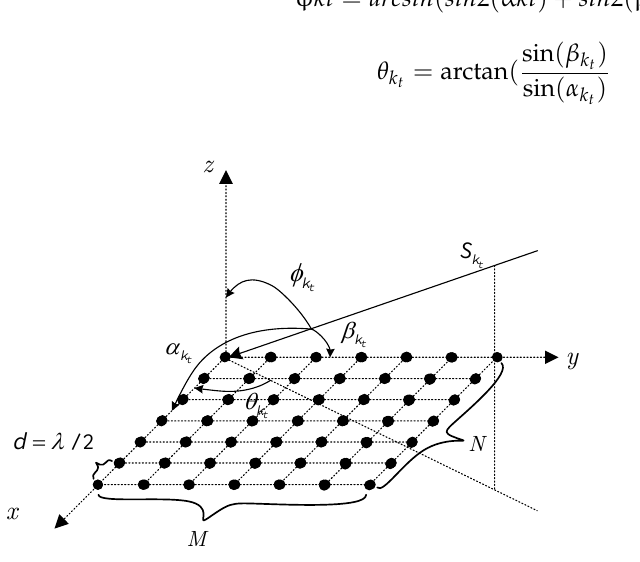
Figure 1. URA signal model.